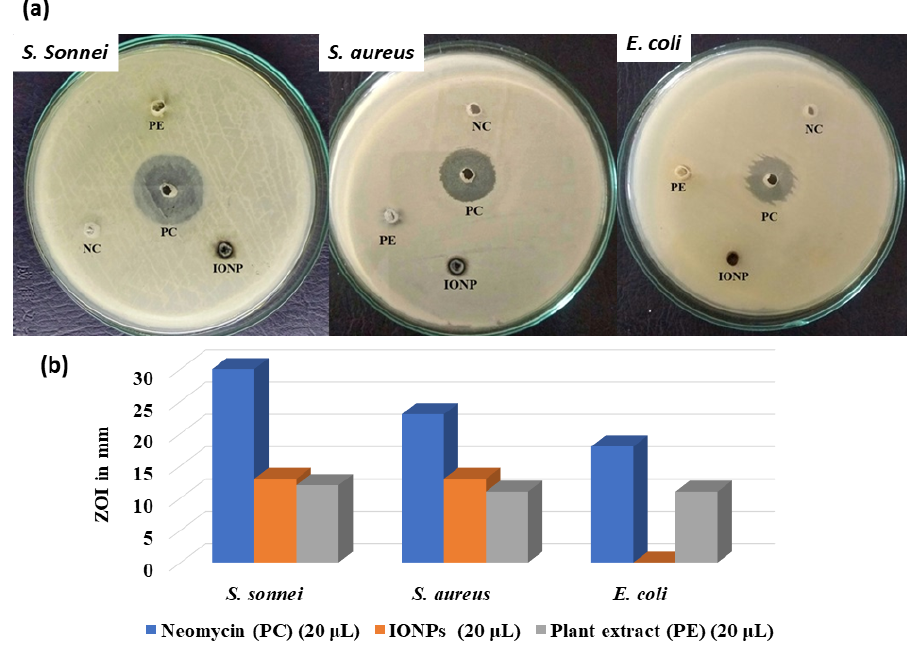
Figure 7. ( a ) Anti-bacterial activity of IONPs against S. Sonnei , S. aureus , and E. coli and ( b ) Comparative graphical representation of bacterial inhibition zone of IONPs on different bacterial strains.